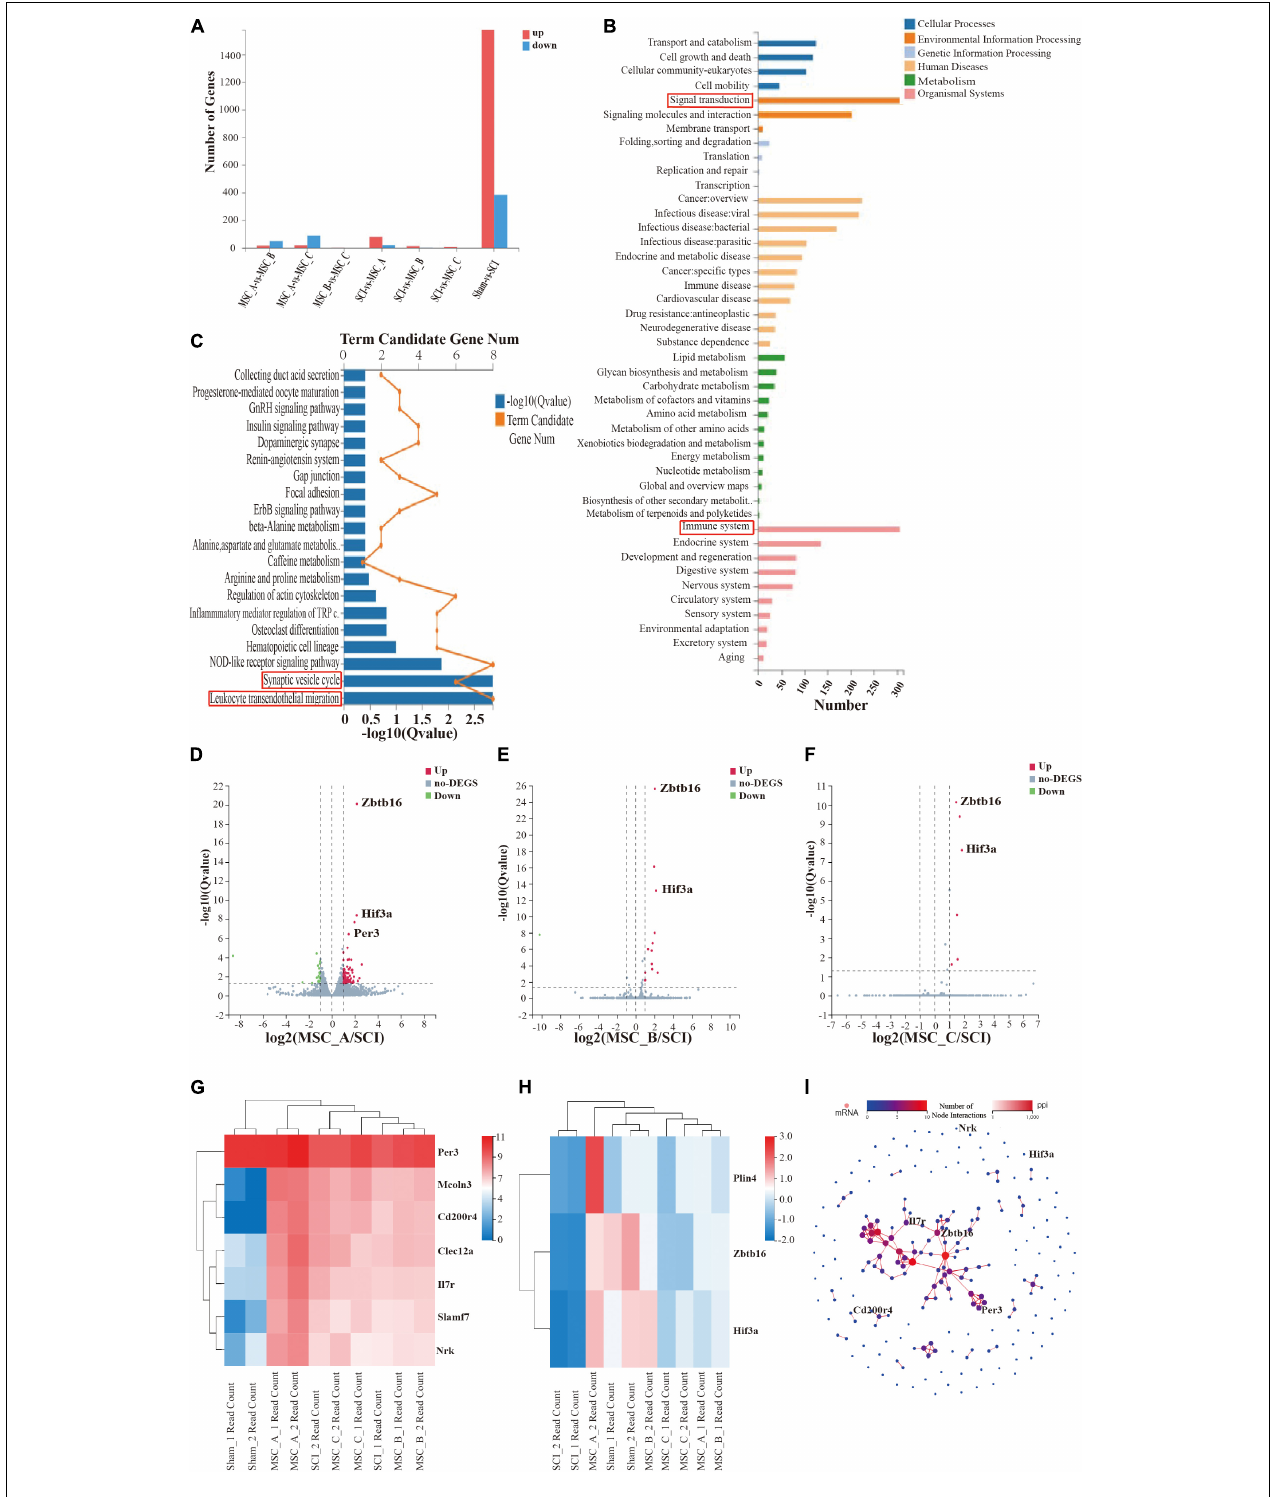
FIGURE 7 | Transcriptome analysis of the spinal cord at 1 week after hUCMSC treatment at dpo 3. (A) Statistics of the number of differentially expressed genes. (B,C) Kyoto Encyclopedia of Genes and Genomes (KEGG) pathway enrichment of signal pathways. Volcano plot of the MSC_A group (D) , the MSC_B group (E) , and the MSC_C group (F) vs. the SCI group. (G,H) The heatmap analysis of the MSC groups vs SCI group. (I) PPI showed the protein–protein interaction of the corresponding protein.